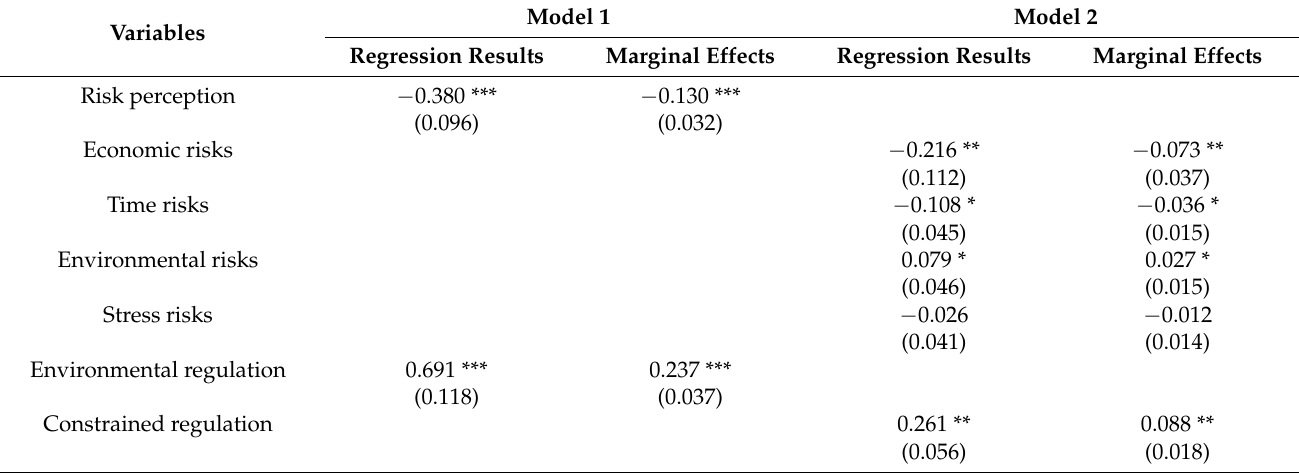
Table 4. Regression estimation results of explanatory variables ( n =